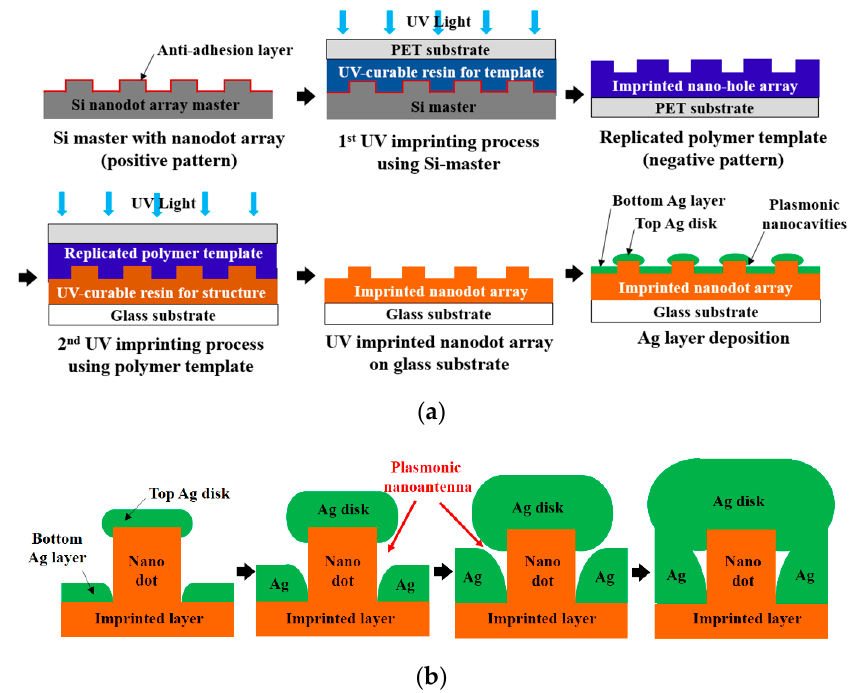
Figure 1. Schematic diagrams of ( a ) the fabrication process for the proposed plasmonic nanoantenna array (PNAA) via UV nanoimprinting and Ag deposition, and ( b ) the plasmonic nanoantenna formation process with increasing Ag deposition